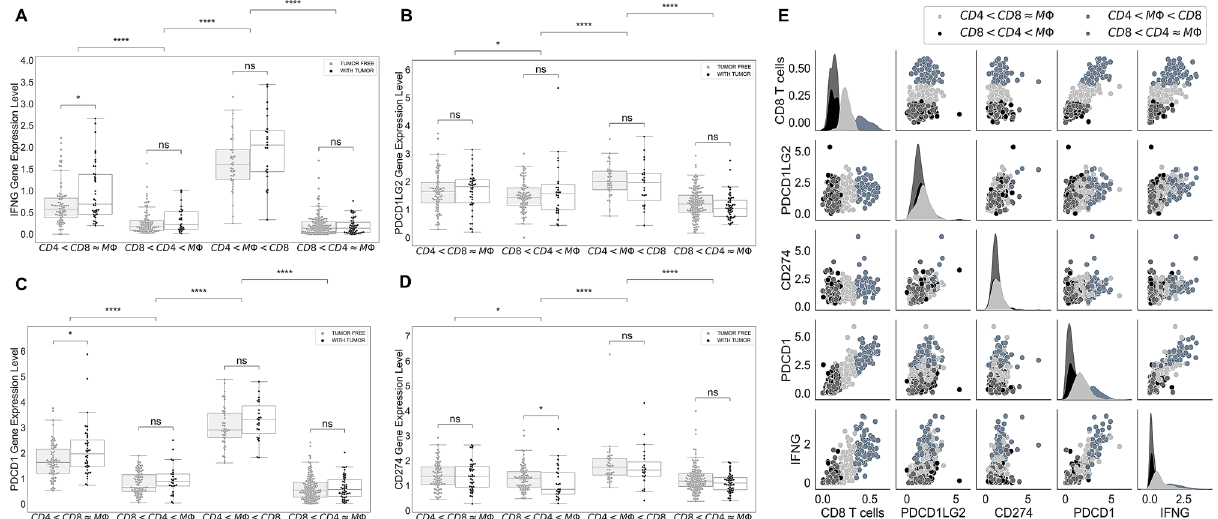
Figure 5. Expression levels of genes encoding PD-1, PD-L1, PD-L2, and IFN γ . Sub-figures ( A )–( D ) indicate the expression levels of INFG, PDCD1LG2, PDCD1 and CD274 in each cluster as a function of tumor status, respectively. Sub-figure ( E ) represents the correlations and distributions of INFG, PDCD1LG2, PDCD1, CD274 expression levels and CD8+ T-cells; color coded based on the clusters.